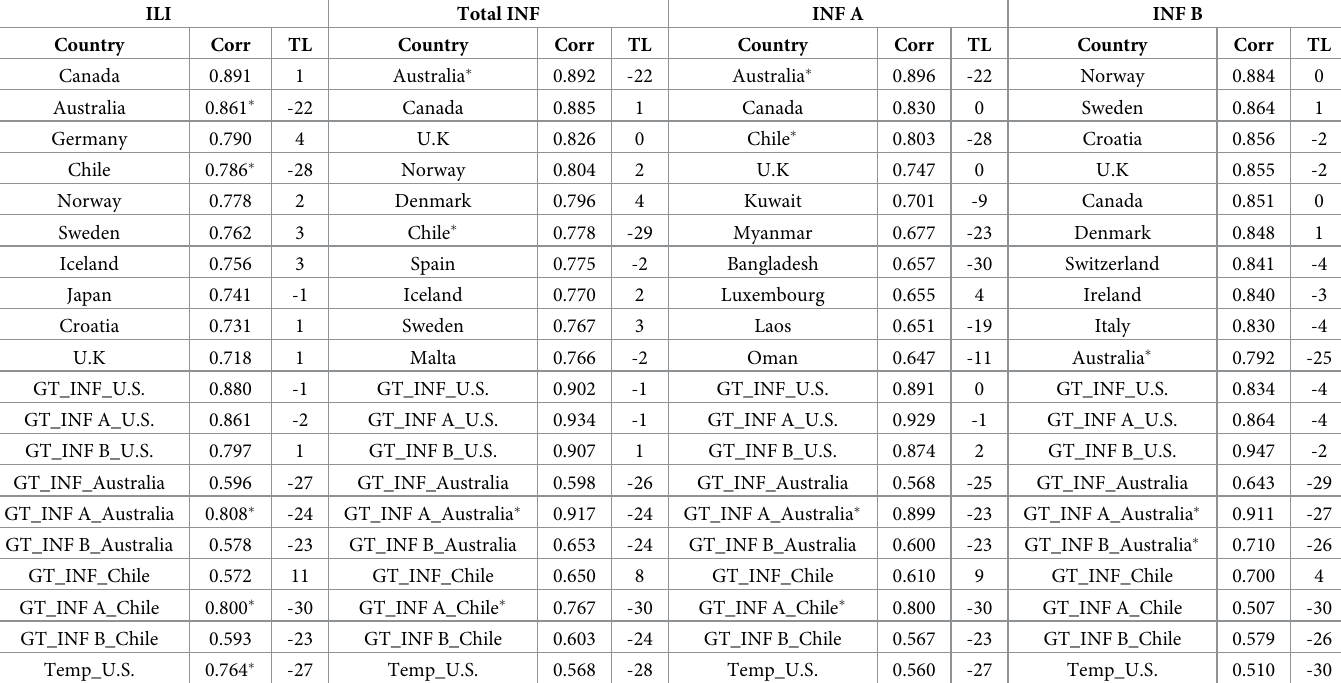
Table 1. Maximum correlation coefficient and time lag with time series of influenza surveillance data in the United States and input variables.